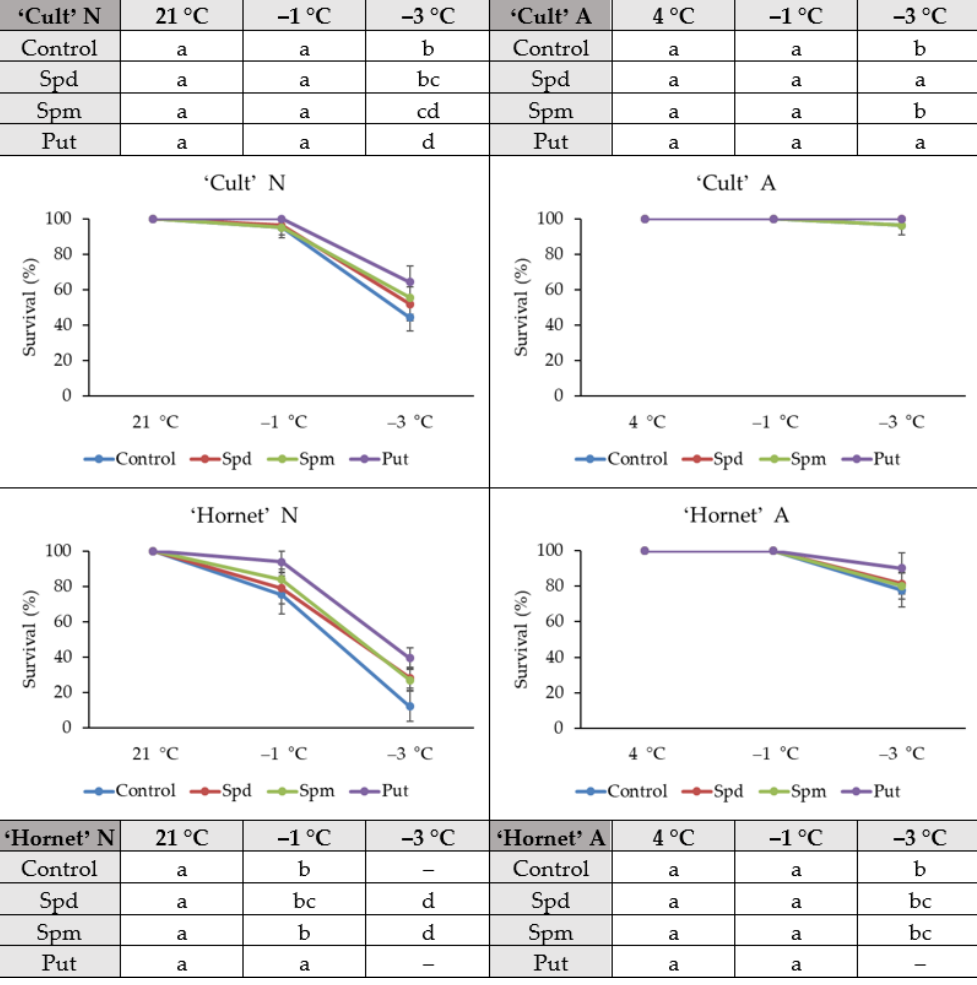
Figure 1. The effect of polyamine (PA) application, cold acclimation (4 °C, 4 days), and increasing cold treatment (from –1 to –3 °C, 2 days) on winter oilseed rape survival. Error bars represent the standard deviation of the mean. Control, Spd, Spm, and Put indicate the type of application (spermidine, spermine, and putrescine, respectively). Capital letters N and A indicate non-acclimation and acclimation, respectively. Different lowercase letters indicate statistically significant difference ( P < 0.05).